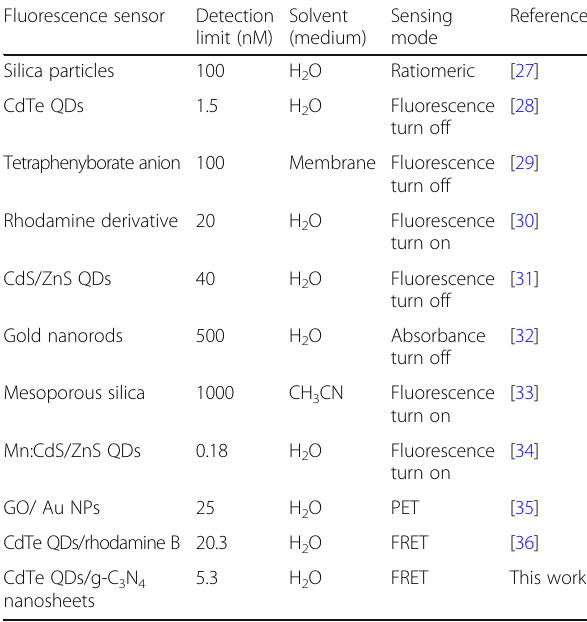
Table 2 The comparison of the previously reported and the present flurescence method for mercury ions Fluorescence sensor